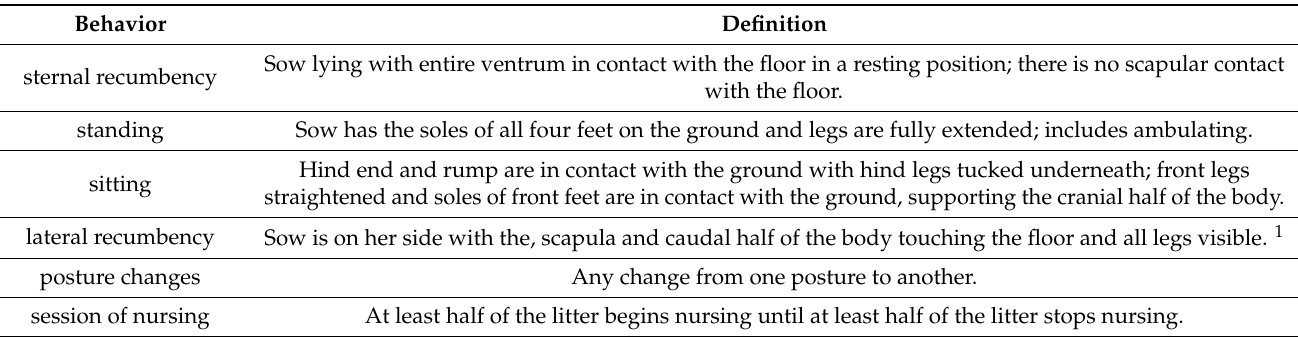
Table 1. Ethogram, outlining sow behaviors in farrowing and their respective